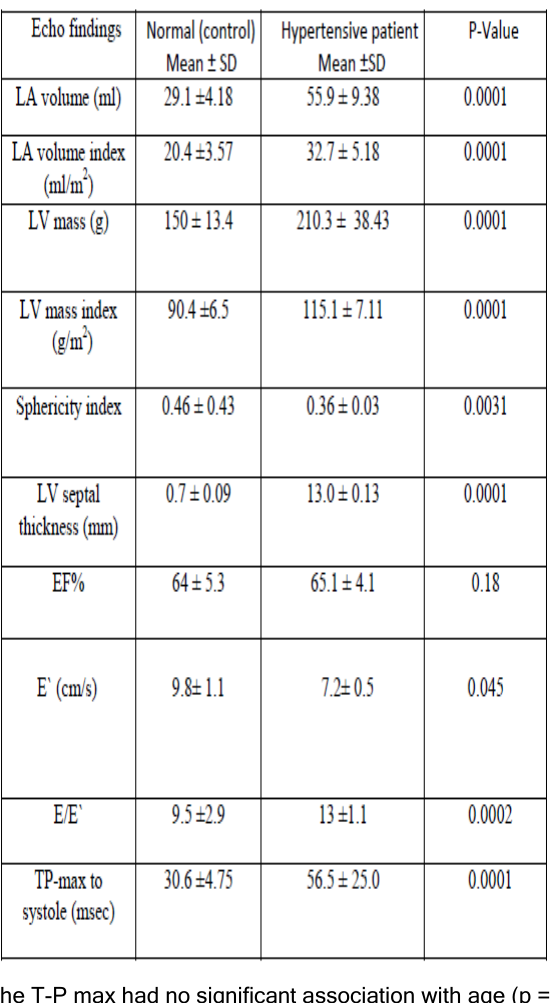
(Table 2) : Echocardiographic findings in hypertensive and control